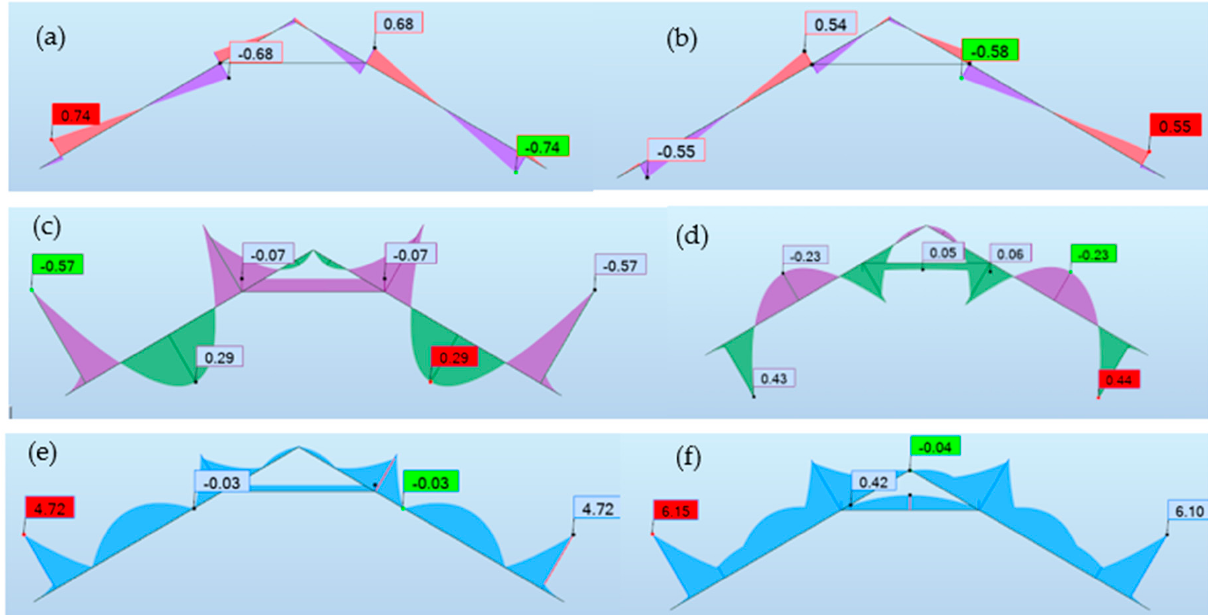
Figure 11. Diagram of internal forces (shear force, bending moment, stresses) for the extreme structure resulting from the acting of dead load and gusts of wind. (a) shear force from dead load, (b) shear force from gusts of wind, (c) bending moment from dead load, (d) bending moment from gusts of wind, (e) stresses from dead load, (f) stresses from gusts of wind.